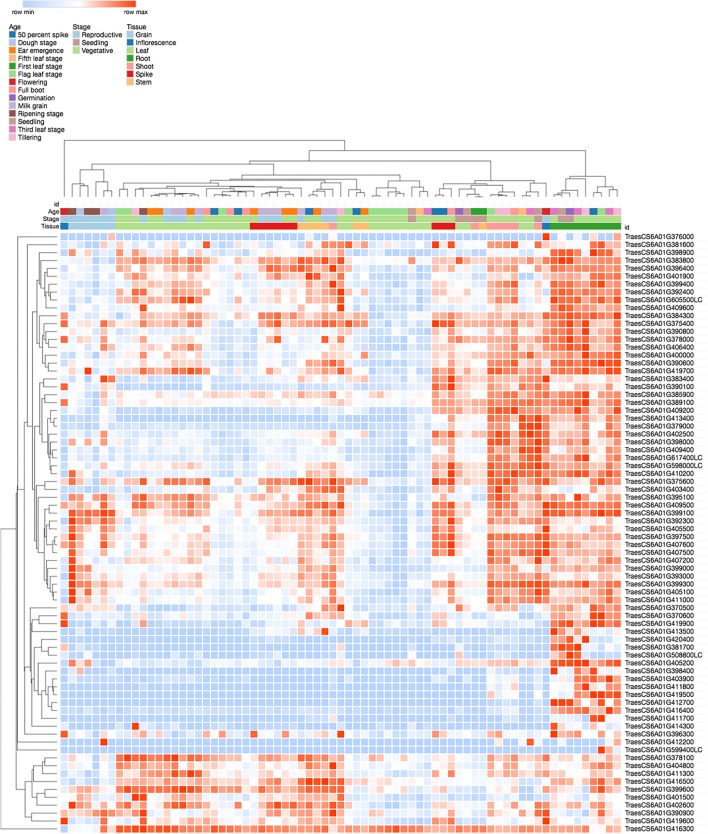
Expression patterns of bread wheat homologs at different age, stage, and tissue specific RNAseq libraries. Heatmap (blue = low; red = high) displayed high expression in root tissues (green) during seedling (pink) and vegetative stage (light green). Genes primarily expressed in the root tissues at seedling and vegetative stages are listed in Table 2.